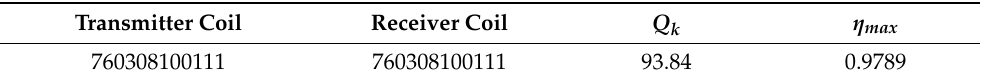
Table 6. Measurement results of the copper